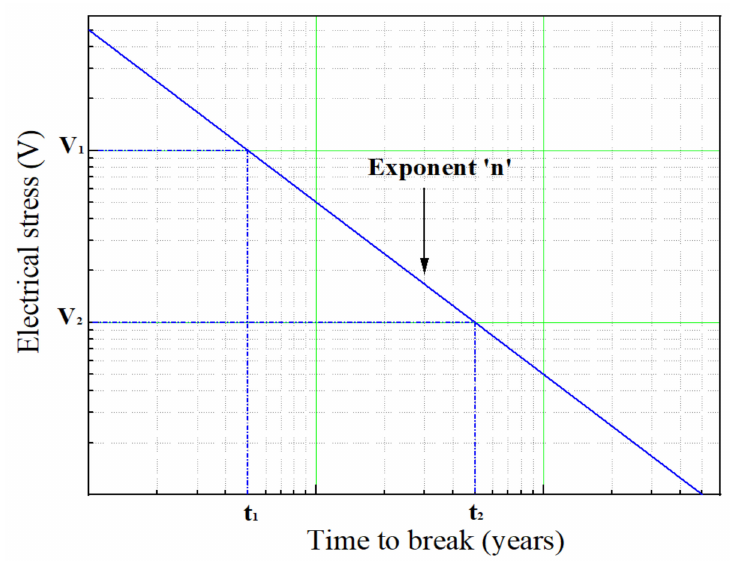
Figure 1. The V-t characteristic